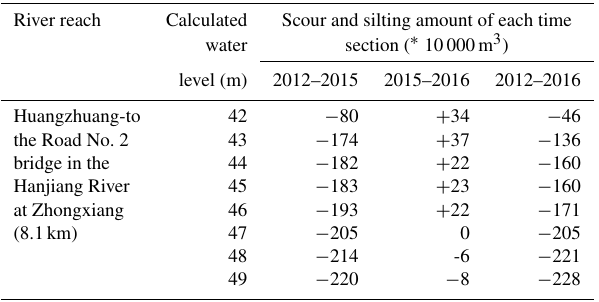
Table 2. Statistics of scour and silting amount in the Huangzhuang– Zhongxiang reach riverbed ( + silting, − scour).